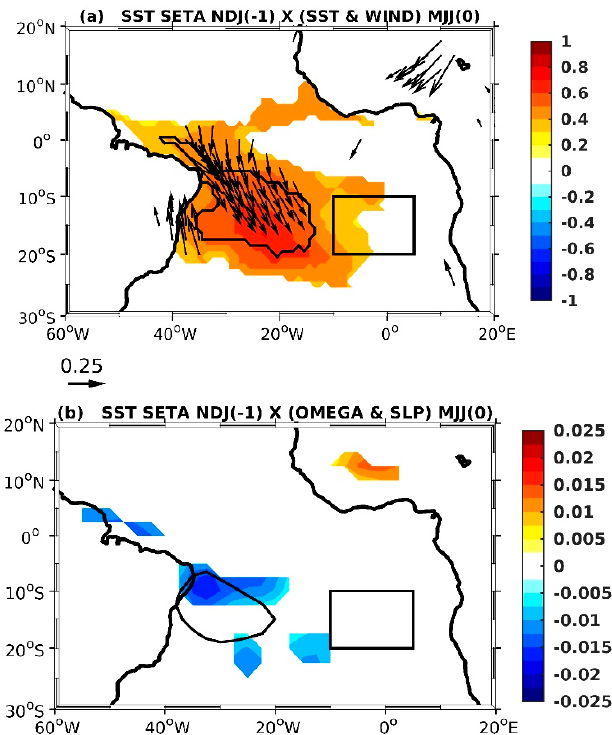
Figure 4. Distribution of the lagged linear correlation / regression of the gridded ( a ) SST (shaded; ◦ C / ◦ C) and surface wind (vectors; m s − 1 / ◦ C) anomalies ( b ) 500 hPa vertical velocity (shaded; Pa s − 1 / ◦ C; negative values indicate upward motion) and the sea level pressure (contours, significant correlation only) anomalies within the entire tropical Atlantic in MJJ with SSTA inside southeastern tropical Atlantic (SETA; 10 ◦ S–20 ◦ S, 10 ◦ W–5 ◦ E; oceanic black box) in NDJ for all the years (56 years) from 1960 to 2015. Only the correlations that are significant at a 95% confidence level, according to the t -test, are plotted for all variables. Contours in ( a ) indicate regions of correlation higher than + 0.5 for SSTA.